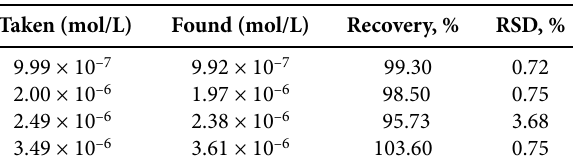
Table 5. Determination of chlorzoxazone in spiked urine samples using the proposed method.